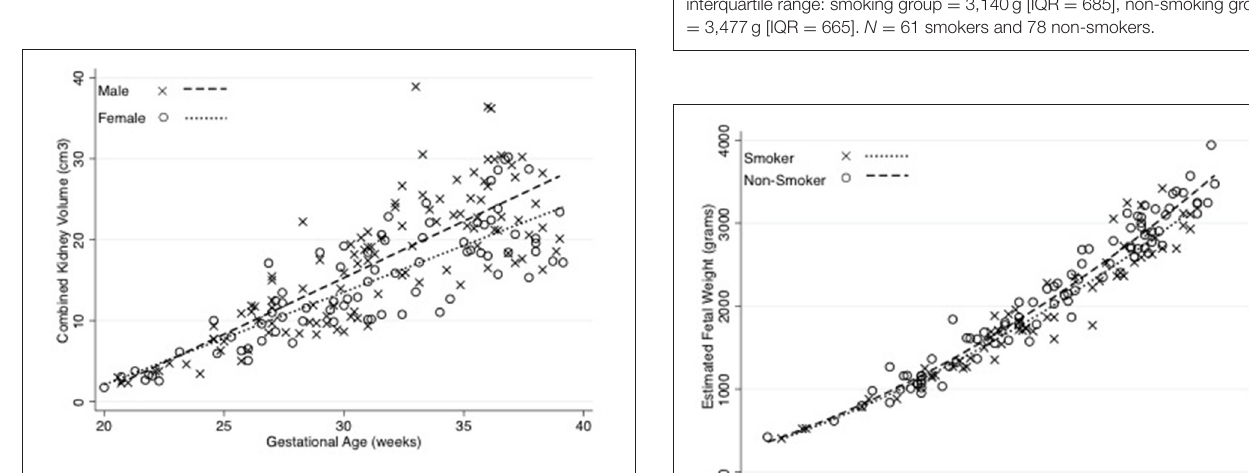
FIGURE 3 | Combined Kidney volume of male and female fetuses throughout gestation. The relationships between fetal kidney volume and gestation were derived using linear regression. The fetal kidney volumes of males were significantly larger than for females ( p = 0.03). Equations are: Combined kidney volume for males = –23.84 + 1.31 (weeks gestation) ( R 2 = 0.70), Combined kidney volume for females = − 19.22 + 1.10 (weeks gestation) ( R 2 = 0.76). N = 117 male and 84 female observations.